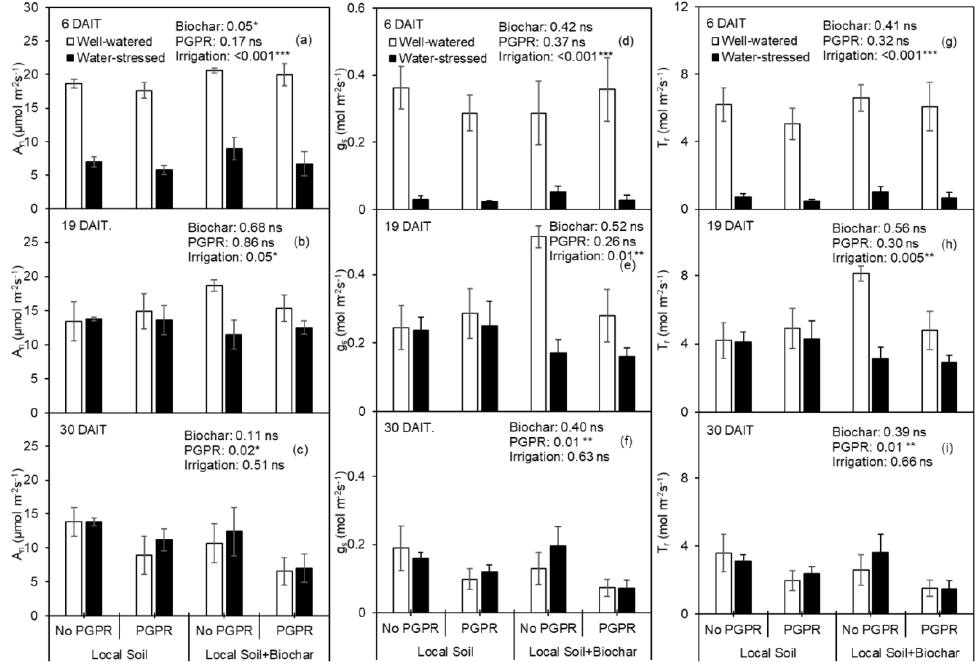
Figure 5. ( a – c ) Photosynthesis rate (A n ), ( d – f ) stomatal conductance (g s ) and ( g – i ) transpiration rate (T r ) of potato leaf as affected by biochar amendment and PGPR inoculation at 6 days after initiation of irrigation treatment (DAIT), 19 DAIT and 30 DAIT, respectively. *, ** and *** indicate significance effect at p < 0.05, p < 0.01 and p < 0.001 level, respectively, and ns indicates the effect was not statistically significant at p < 0.05 level.